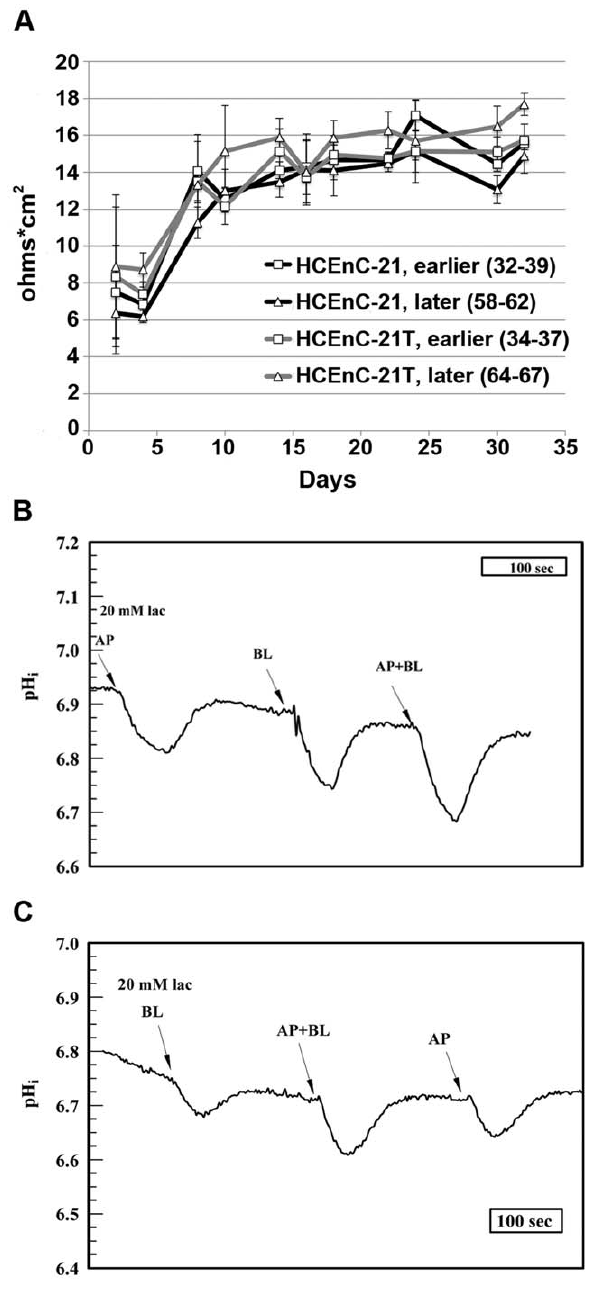
Figure 6. HCEnC-21 and HCEnC-21T retain typical corneal endothelial barrier integrity and pump function. (A) Cells were plated in 12-well transwell inserts (0.4 m m) at a density of 100,000 cells per transwell and transendothelial resistance (TER) was measured every 2 or 4 days over the course of 4.5 wk. Note that earlier (32–39) and later (58–67) passages of both HCEnC-21 and HCEnC-21T established a typical corneal endothelial barrier of 15 V *cm 2 after about 2 wk and maintained this barrier for 2.5 more wk. (B,C) HCEnC-21 (B) and HCEnC-21T (C) were grown to confluence (3,000 cells/cm 2 ) in perfusion chambers and 20 mM lactate was applied to their apical, basolateral or both cell membranes. Facilitated lactate uptake is H + coupled and was measured indirectly by detecting intracellular pH changes using the BCECF-AM fluorescent dye. Temporal acidification of both HCEnC-21 and HCEnC-21T was observed after lactate pulses to the apical and basolateral membrane. Error bars indicate mean 6 SEM. *, P , 0.05.